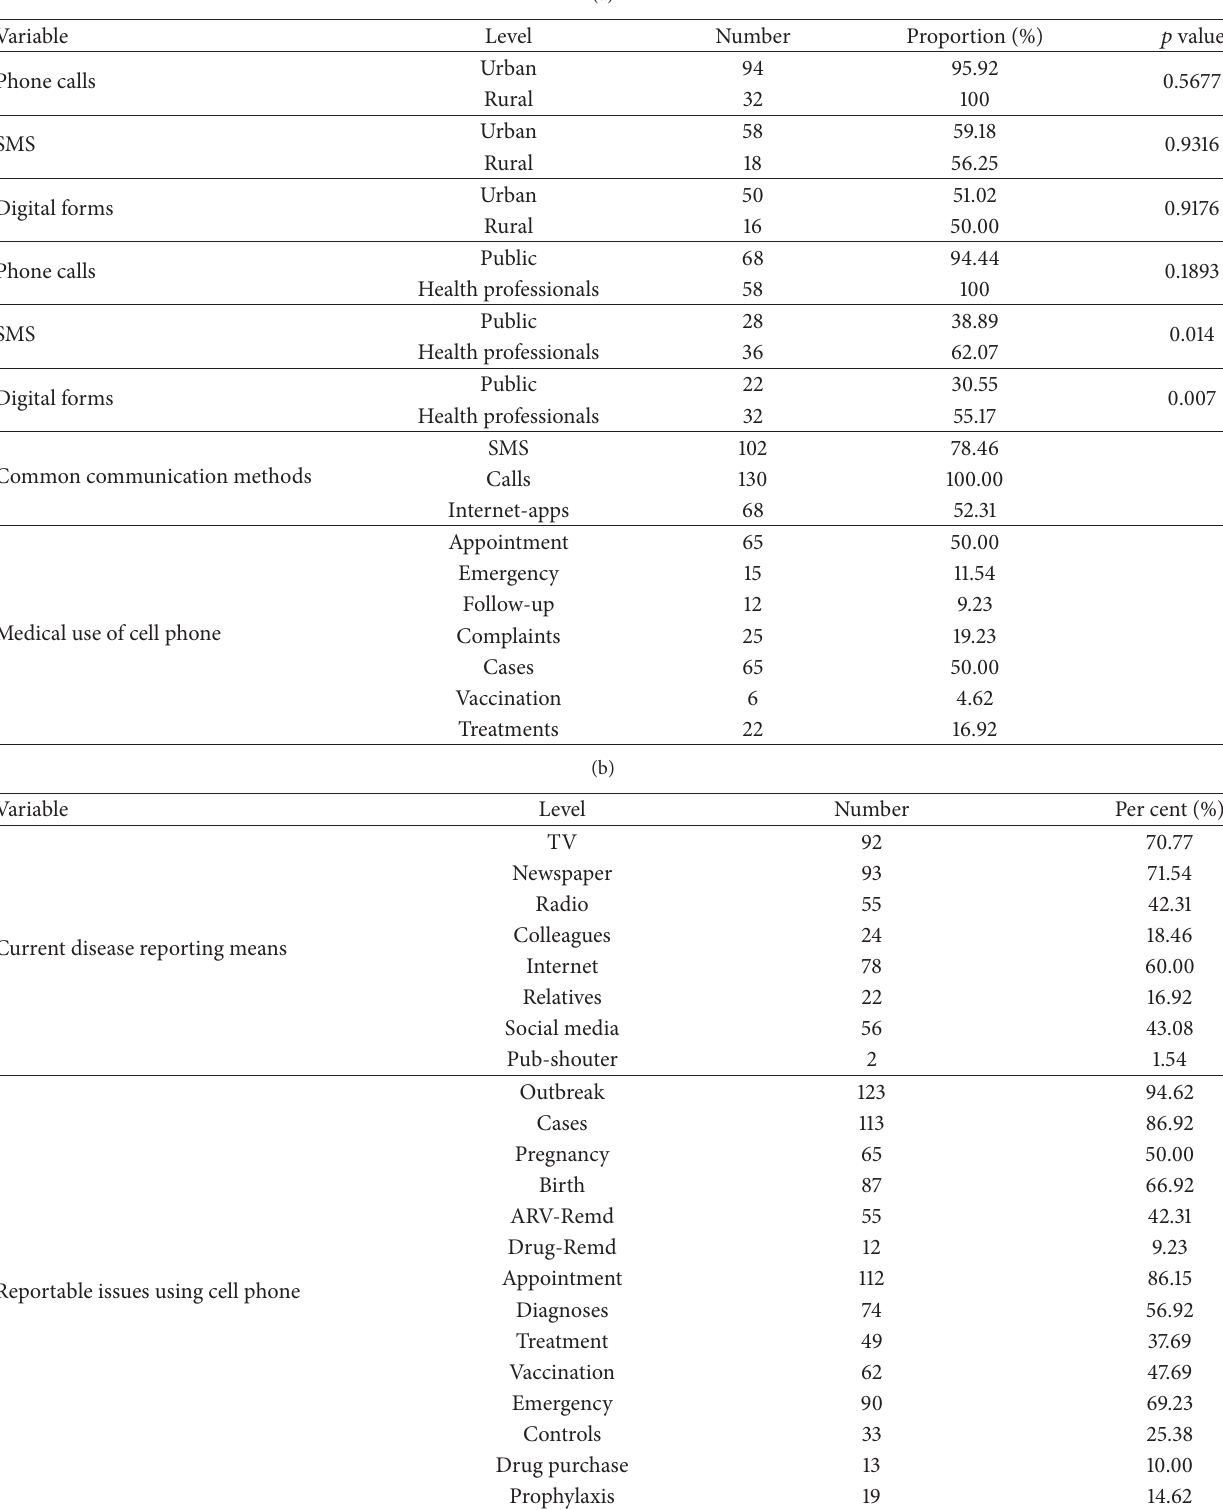
Table 1: (a) Comparison and recapitulation of information collected from respondents. (b) Compassion and recapitulation of information collected from